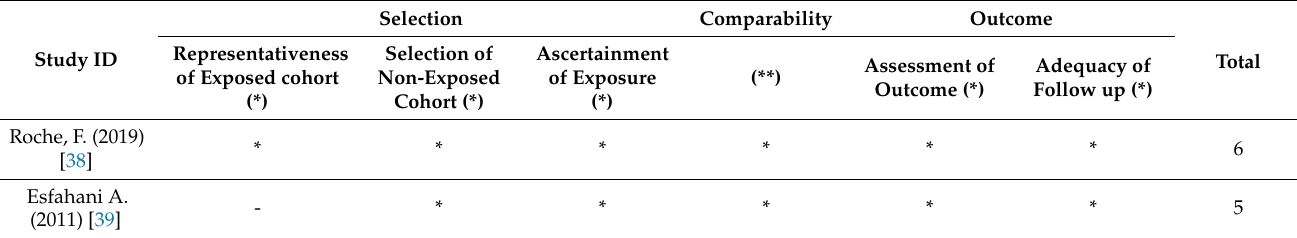
Figure 1. ROB2 quality assessment. Table 3. Newcastle–Ottawa Scale assessment .